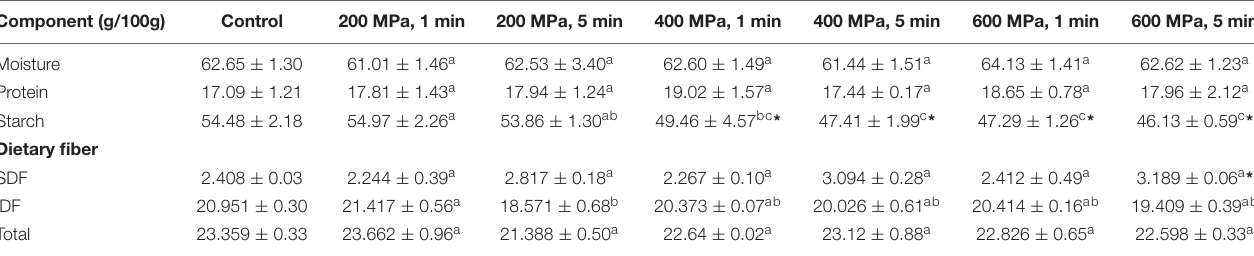
FIGURE 3 | Texture profile of control and HPP chickpea samples (where, 2K1 = 200 MPa, 1 min; 2K5 = 200 MPa, 5 min; 4K1 = 400 MPa, 1 min; 4K5 = 400 MPa, 5 min; 6k1 = 600 MPa, 1 min; and, 6K5 = 600 MPa, 5 min). Bars bearing different letter for the same parameter are significantly ( p < 0.05) different. Bars bearing * for the same parameter are significantly ( p < 0.05) different to the control. TABLE 2 | Moisture, protein, starch and dietary fiber (soluble, insoluble, and total dietary fiber) content of control and high pressure processed cooked chickpeas. Component